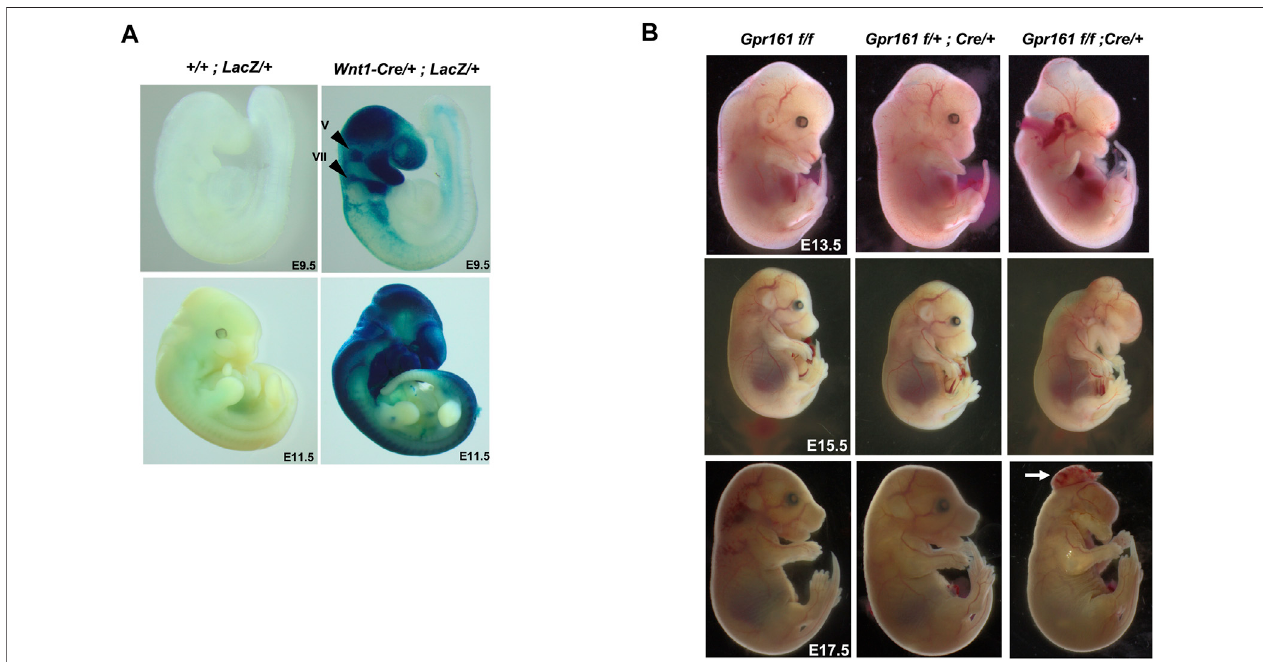
FIGURE1| The Wnt1 lineagespeci fi cdeletionof Gpr161 resultsinprotrusivetectumdefectsandcraniofacialdefects. (A) X-galstainingof Rosa-LacZ;Wnt1-Cre/+ and Rosa-LacZ at E9.5 and E11.5. V: trigeminal ganglia, VII: and facialnerve ganglia (B) Gross morphology of Gpr161 f/f , Gpr161 f/+ ;Wnt1-Cre/+ , Gpr161 f/f ;Wnt1-Cre/+ ( Gpr161 cKO) at E13.5, 15.5 and 17.5. The white arrow indicates encephalocele in